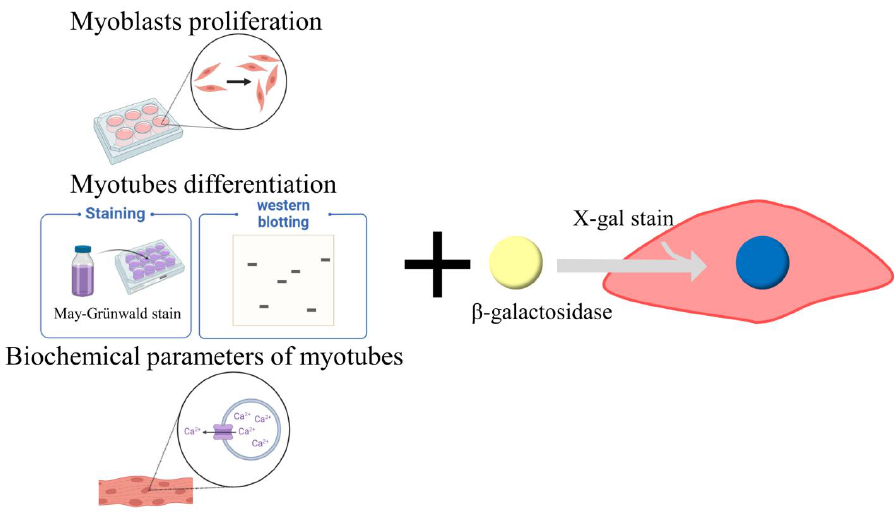
Figure 1. Cell-based evaluation for skeletal muscle cell senescence. Created using BioRender.com (accessed on 10 September 2022).